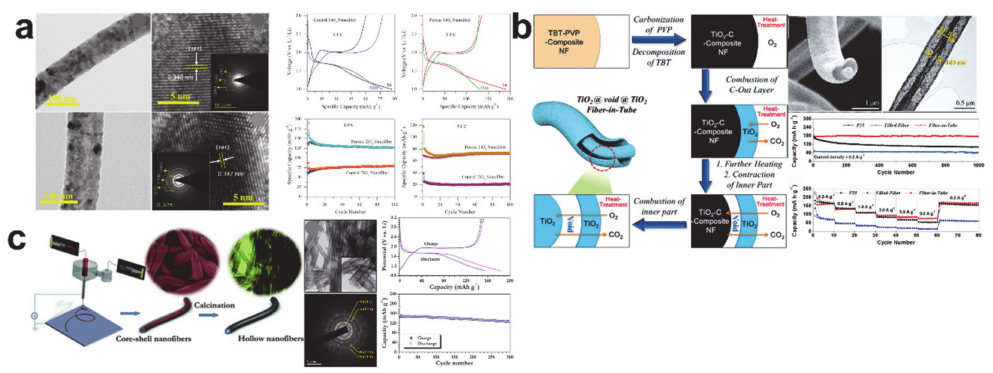
Figure 7. Nanostructured TiO 2 anode materials and electrochemical performances. ( a ) Control and porous TiO 2 nanofiber (reprinted with permission from [87]; copyright 2017 Royal Society of Chemistry), ( b ) fiber-in-tube structured TiO 2 nanofiber (reprinted with permission from [88]; copyright 2015 John Wiley and Sons), and ( c ) hollow TiO 2 nanofiber (reprinted with permission from [89]; copyright 2013 Royal Society of Chemistry). TBT, tetra- n -butyl titanate; PVP, polyvinyl